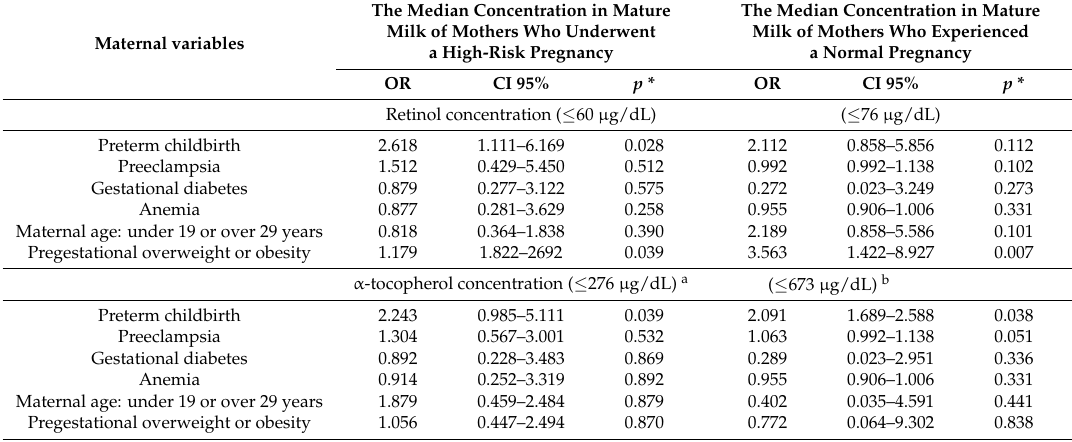
Table 3. Variables associated with low concentrations of retinol and α -tocopherol in mothers that underwent a high-risk pregnancy ( n = 95). The Median Concentration in Mature The Median Concentration in Mature Milk of Mothers Who Experienced Milk of Mothers Who Underwent Maternal variables a High-Risk Pregnancy